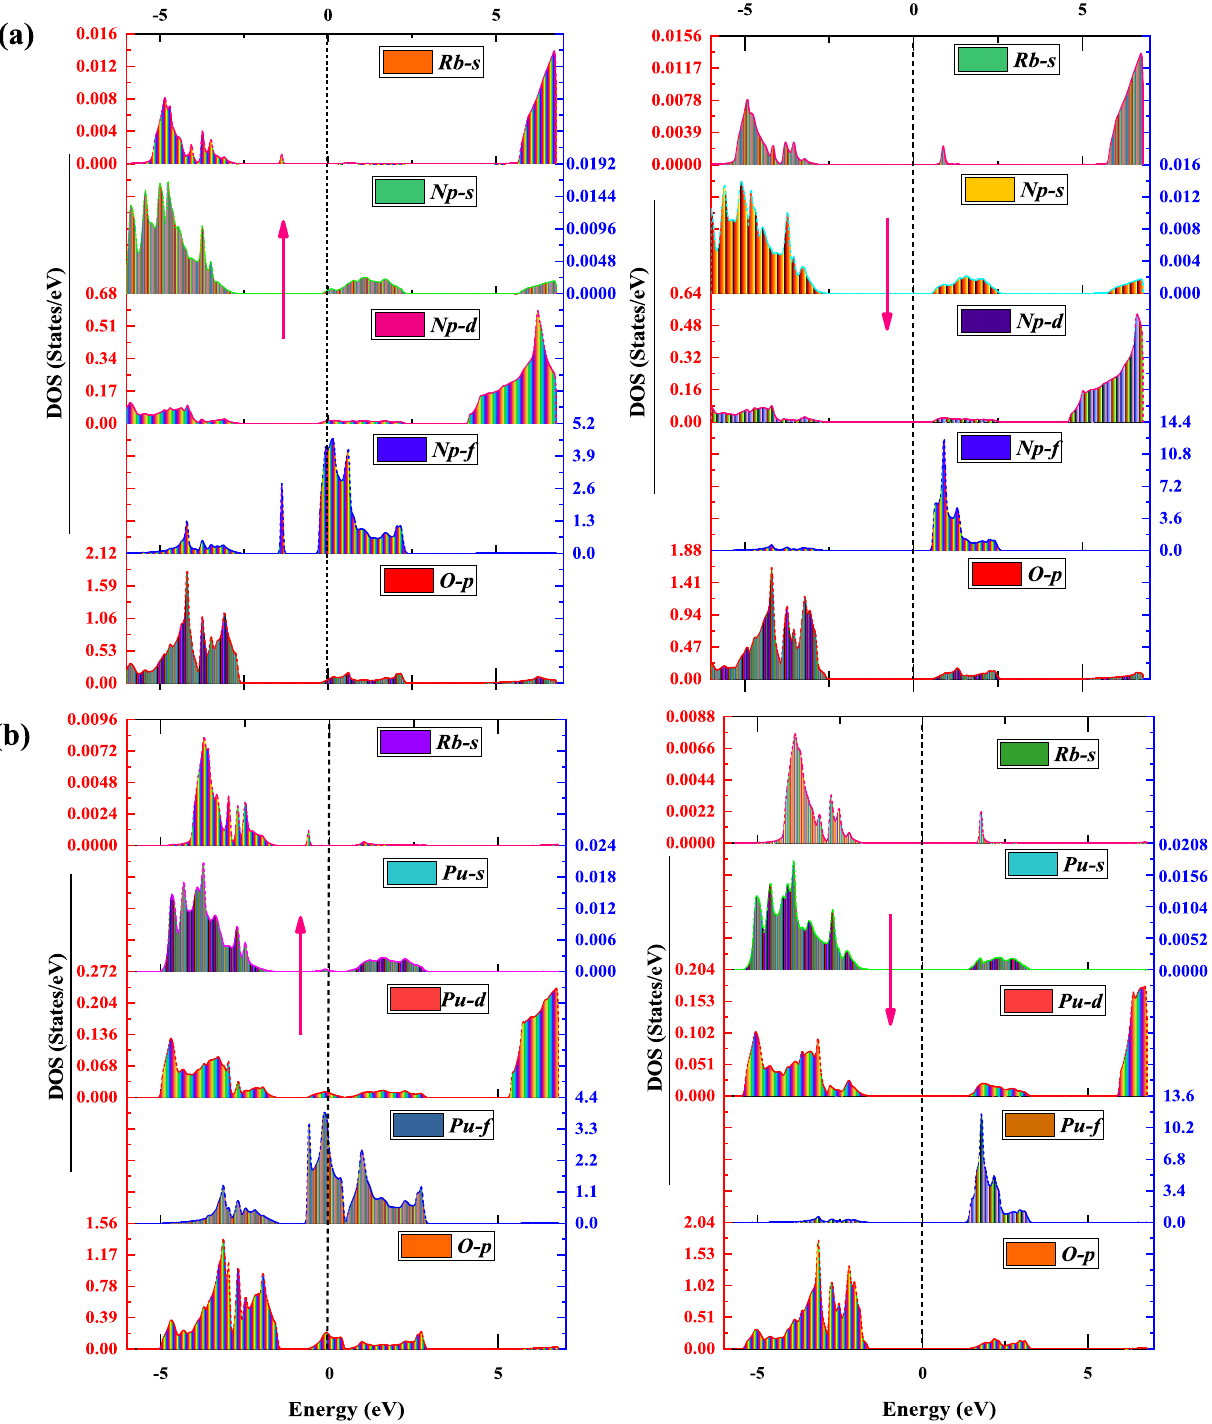
Figure 5. Partial density of states ( P DOS) forecasted via GGA + mBJ approximations for ( a ) RbNpO 3 and ( b ) RbPuO 3